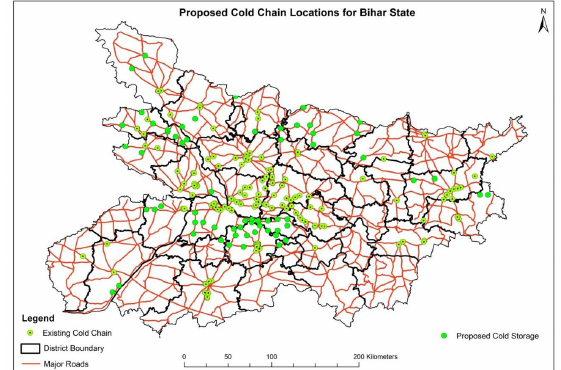
Figure 11. A significant horticulture region in Bihar obtained by union of top two classes of clustering outputs from potato and horticulture crop proportion. Figure 8. Horticulture land use proportions for villages in Bihar. The map was created from the LU / LC map using plantations & above crop area